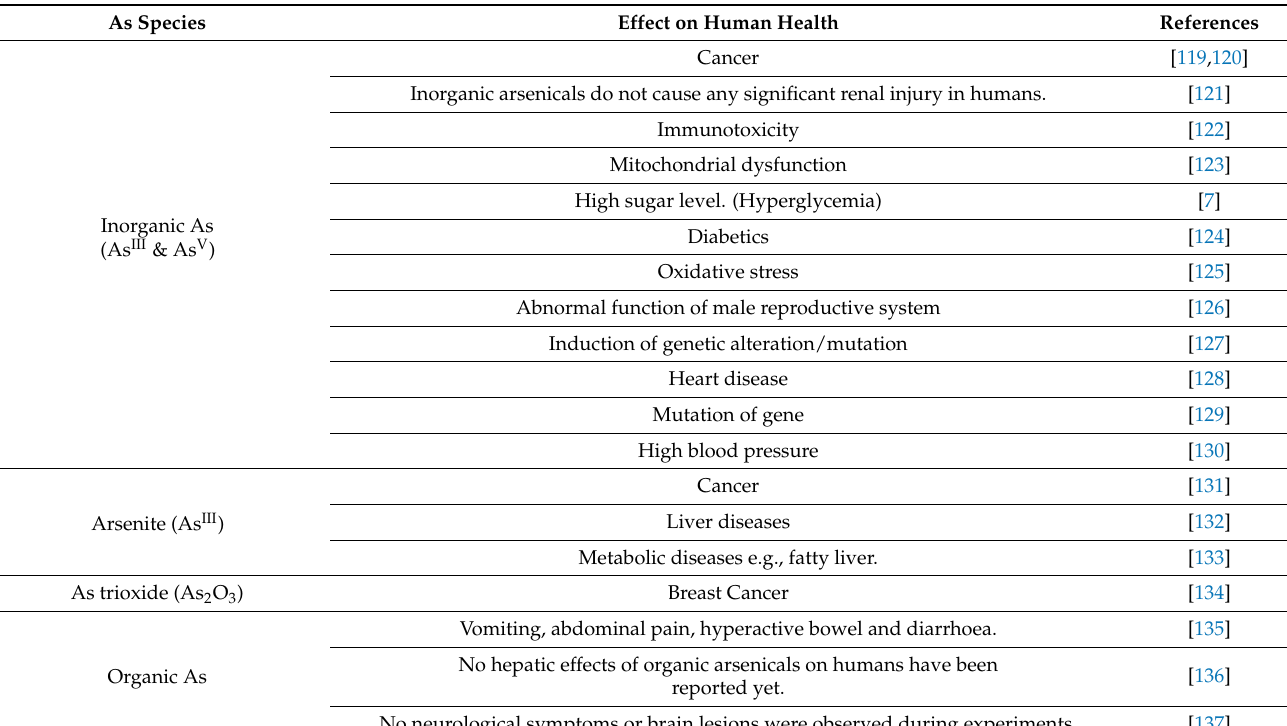
Table 13. Health complications induced by different As species